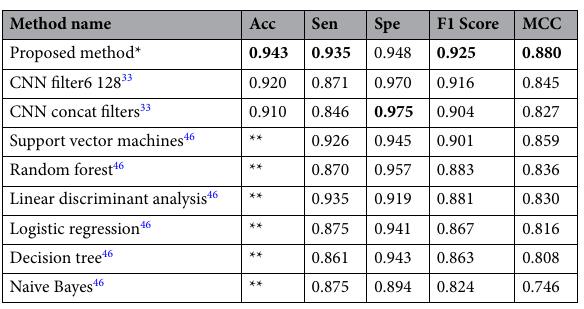
Table 5. Performance comparison of pre-miRNA classification. *Average value of the stratified 5-folds CV results. **Data not